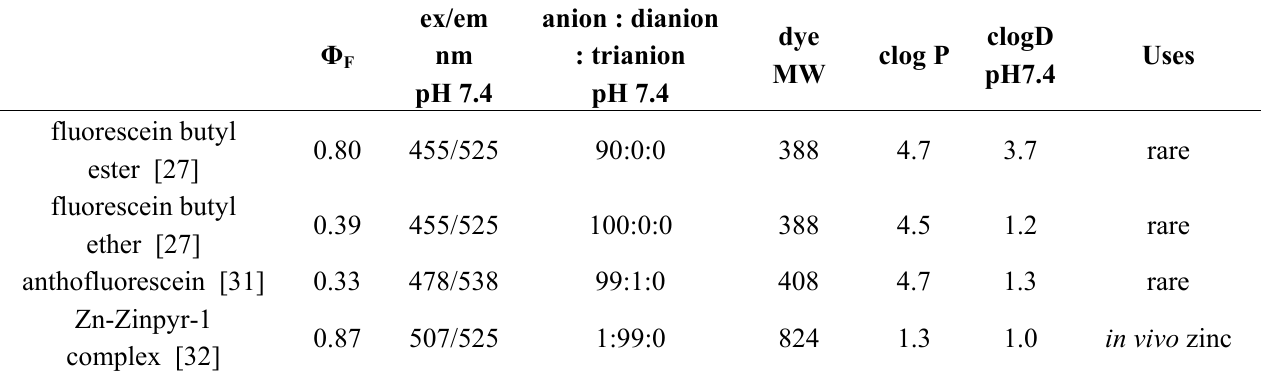
Table 6. Physicochemical properties of fluorescein derivatives not approved for use in humans. ex/em anion : dianion clogD dye Uses clog P Φ nm : trianion F pH7.4 MW pH 7.4 pH 7.4 fluorescein butyl 0.80 455/525 90:0:0 388 4.7 3.7 rare ester [27] fluorescein butyl 0.39 455/525 100:0:0 388 4.5 1.2 rare ether [27] anthofluorescein [31] 0.33 rare Zn-Zinpyr-1 0.87 507/525 1:99:0 824 1.0 in vivo